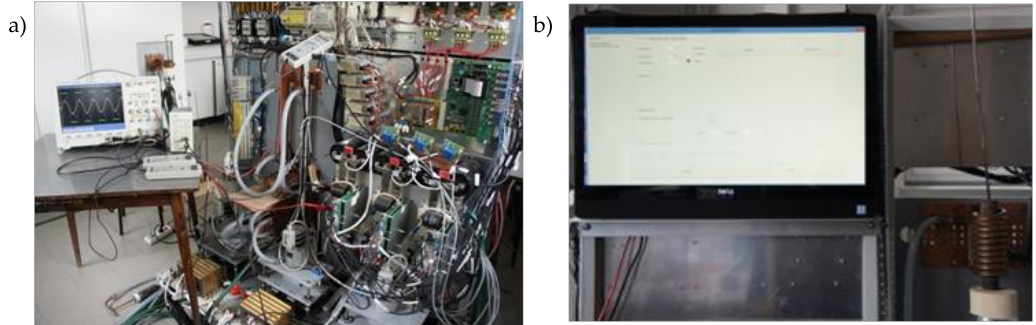
Figure 14. Photograph of the model of the generator for induction heating with a controlled LLC system: ( a ) back side and ( b ) front